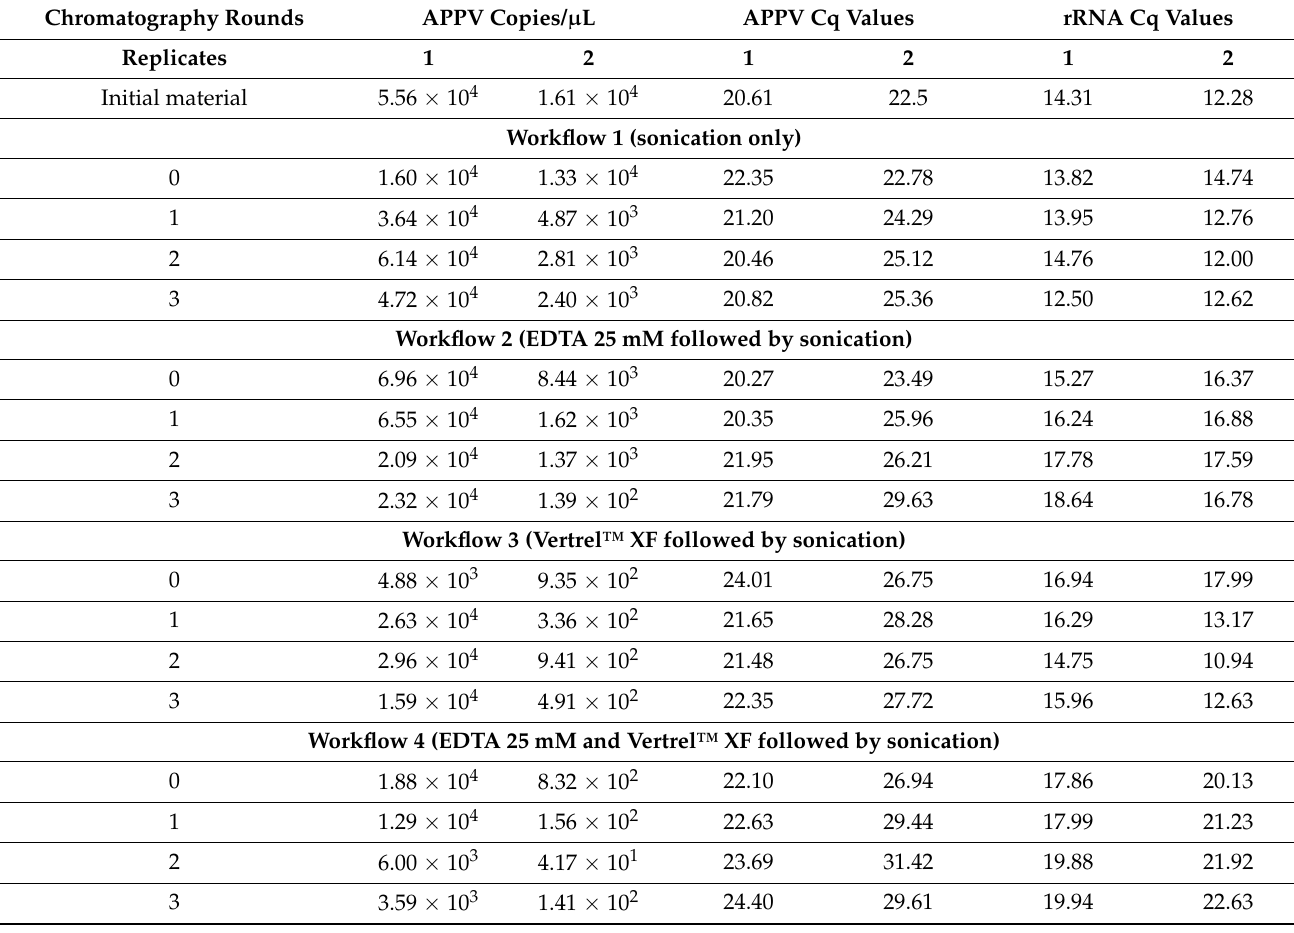
APPV and rRNA qPCR results after sample processing with the different workflows and number of chromatography